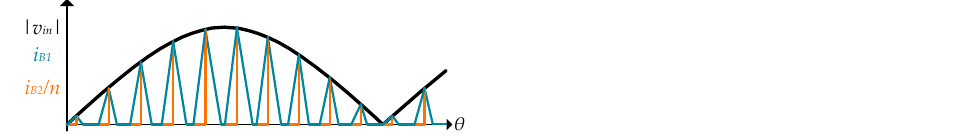
Figure 5. DAB input and output currents evolution with the rectified input voltage. In black rectified ac mains, in blue is the current of rectified ac mains, and in orange is the rectified secondary current of the DAB.